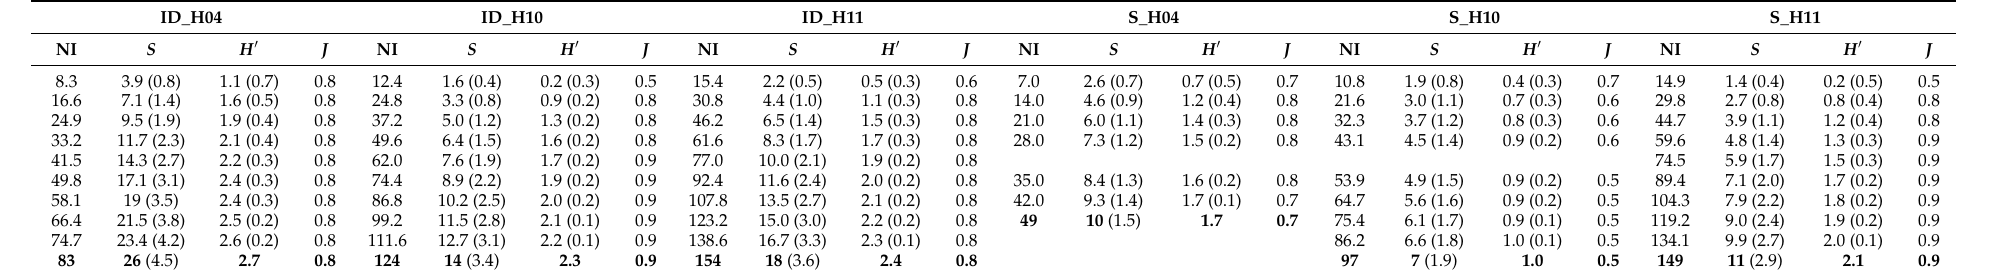
Table 3. Rarefaction of richness ( S ), evenness ( J ), and Shannon diversity indices ( H (cid:48) ) of the six grape-associated S. cerevisiae populations analyzed from two Malbec vineyards (ID and S) in the ZARM region during three harvests (H04, H10, and